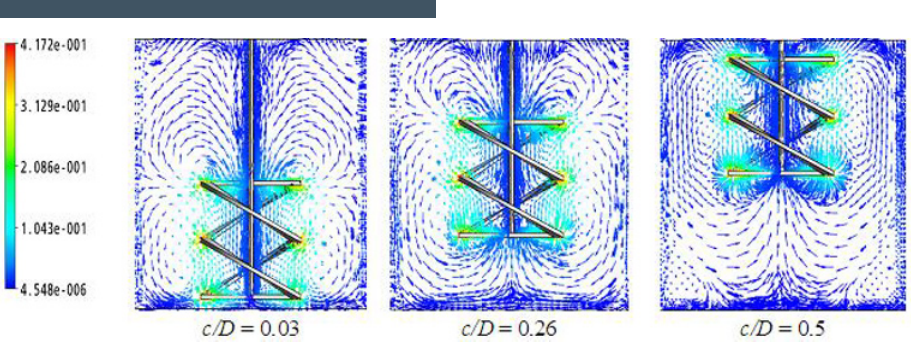
Figure 17. Velocity vectors for double helical ribbon impeller, at n = 0.8, Re